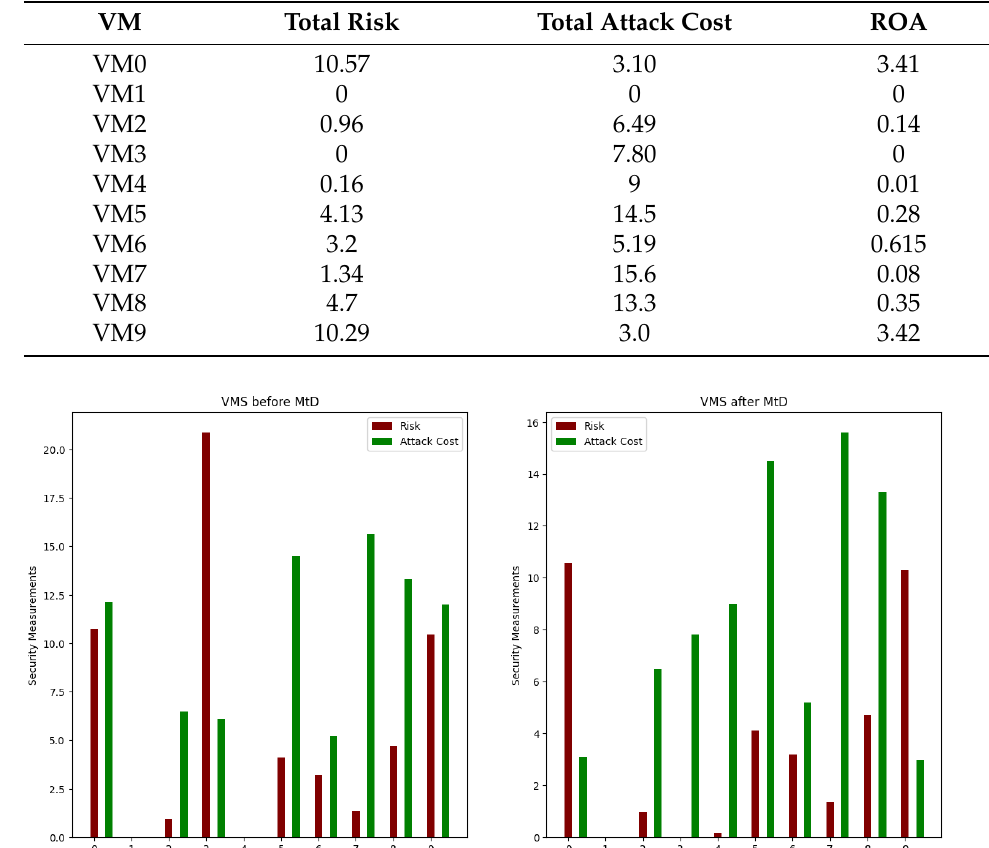
Figure 5. Comparison of security metrics on VMs before and after applying shuffle MtD.